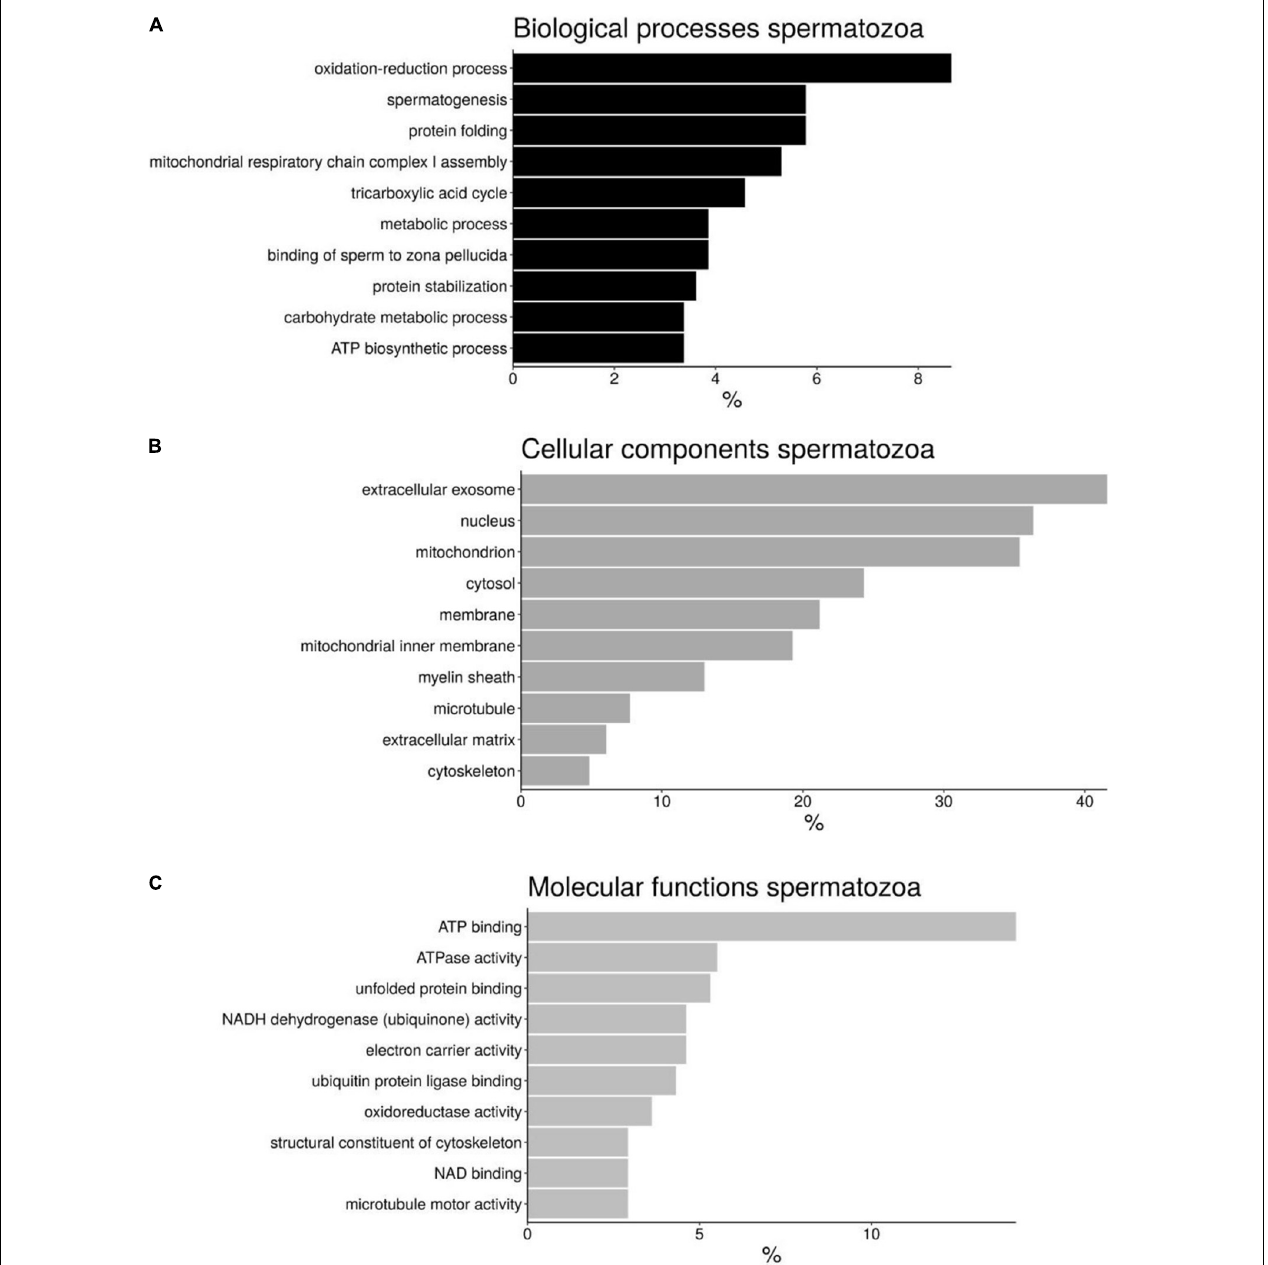
FIGURE 3 | Bar chart representing the gene ontology annotations of protein identified in bottlenose dolphin spermatozoa according to biological processes (A) , cellular components (B) , and molecular functions (C)